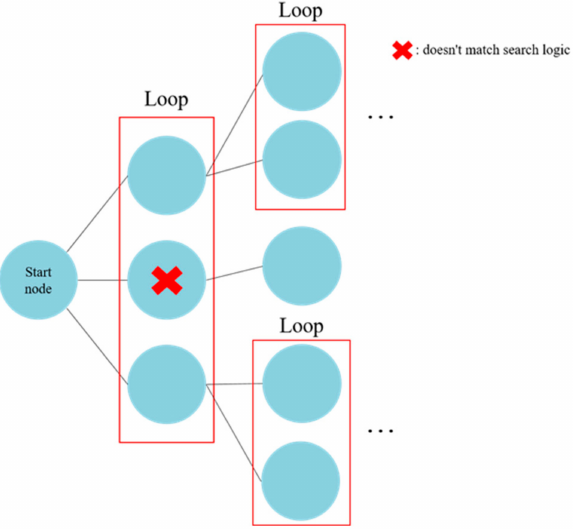
Figure 5. Principles of search